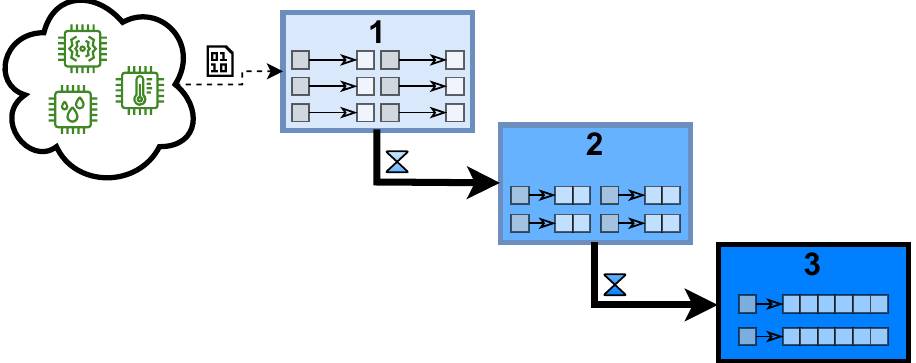
Figure 7. Simplification of a sample Cascading Polyglot Persistence dataflow setup with three different data models: key-value, short column, and long column. The first data model is in charge of providing a fast way for data ingestion, increasing its I/O ratio. The third data model is aimed to provide excellent historical querying, and the second data model is in charge of providing a hybrid and intermediate solution between the other